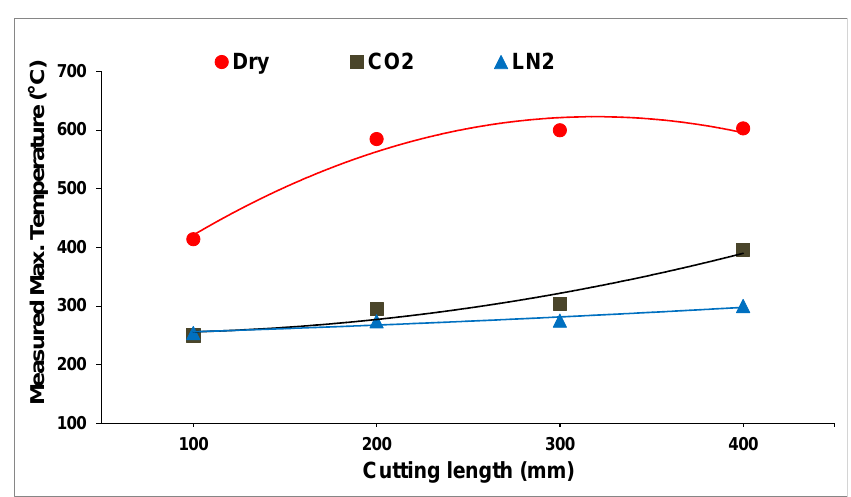
Figure 12. Measured maximum temperature during machining processes under various conditions.